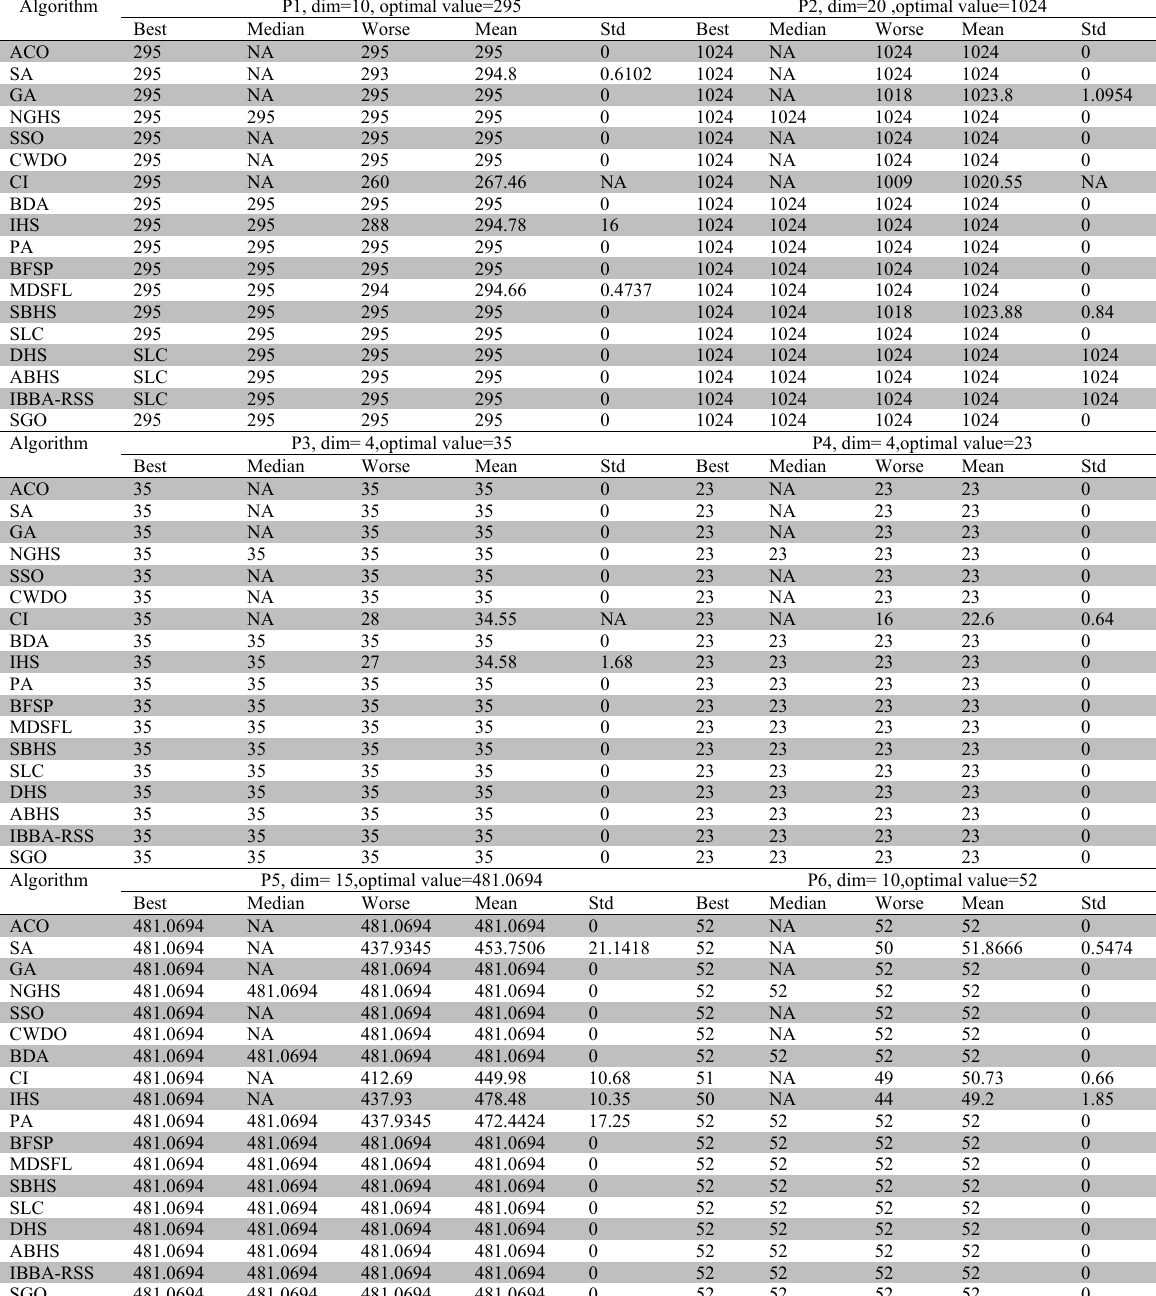
Results of 10 low dimensional 0-1 KP problems, referred from different research